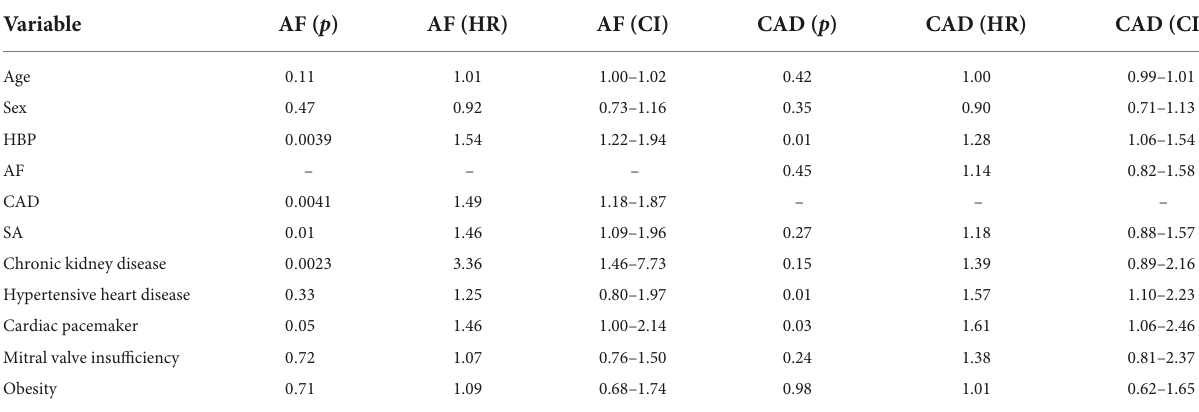
TABLE 4 Results of Cox proportional hazards (PH)